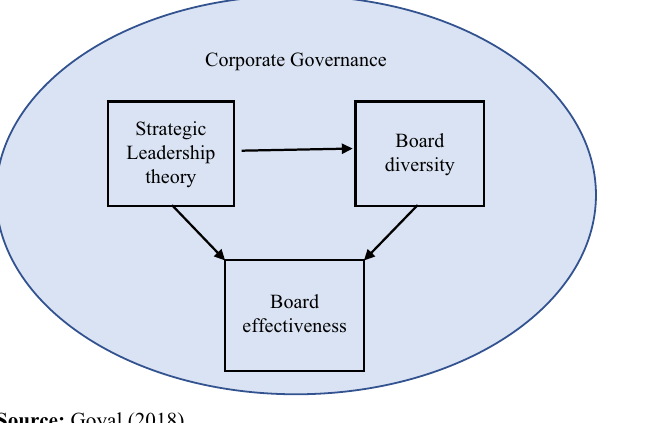
Figure 1. Strategic